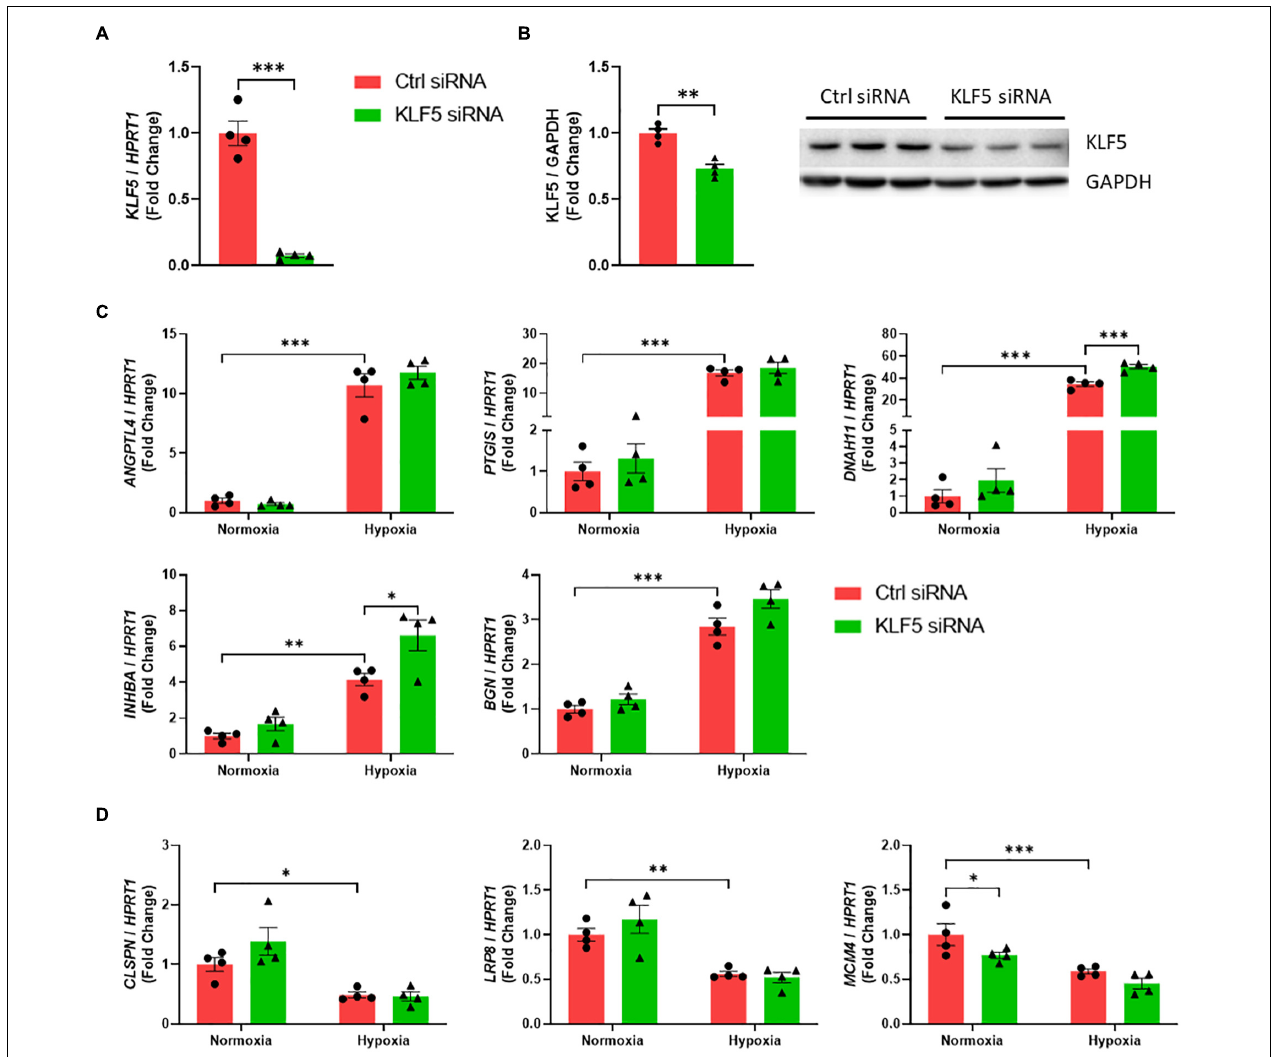
FIGURE 3 | KLF5 does not regulate hypoxic gene expression in ECs. (A) KLF5 mRNA levels in HUVECs after 24 h of hypoxia were detected via qPCR ( n = 4). (B) KLF5 protein levels in HUVECs after 24 h after siRNA transfection were detected by Western blot ( n = 4). For each sample, 30 µ g of protein were loaded onto polyacrylamide gels. Chemiluminescence with an exposure time of 398 s (KLF5) or 13 s (GAPDH). (C) mRNA levels of genes, which were upregulated under hypoxia, were detected using qPCR after siRNA-mediated KLF5 -knockdown in combination with hypoxia ( n = 4). (D) mRNA levels of genes, which were downregulated under hypoxia, were detected using qPCR after siRNA-mediated KLF5 -knockdown in combination with hypoxia ( n = 4). Each dot resembles the mean value of all technical replicates from an independent experiment. ∗ p ≤ 0.05, ∗∗ p ≤ 0.01, ∗∗∗ p ≤